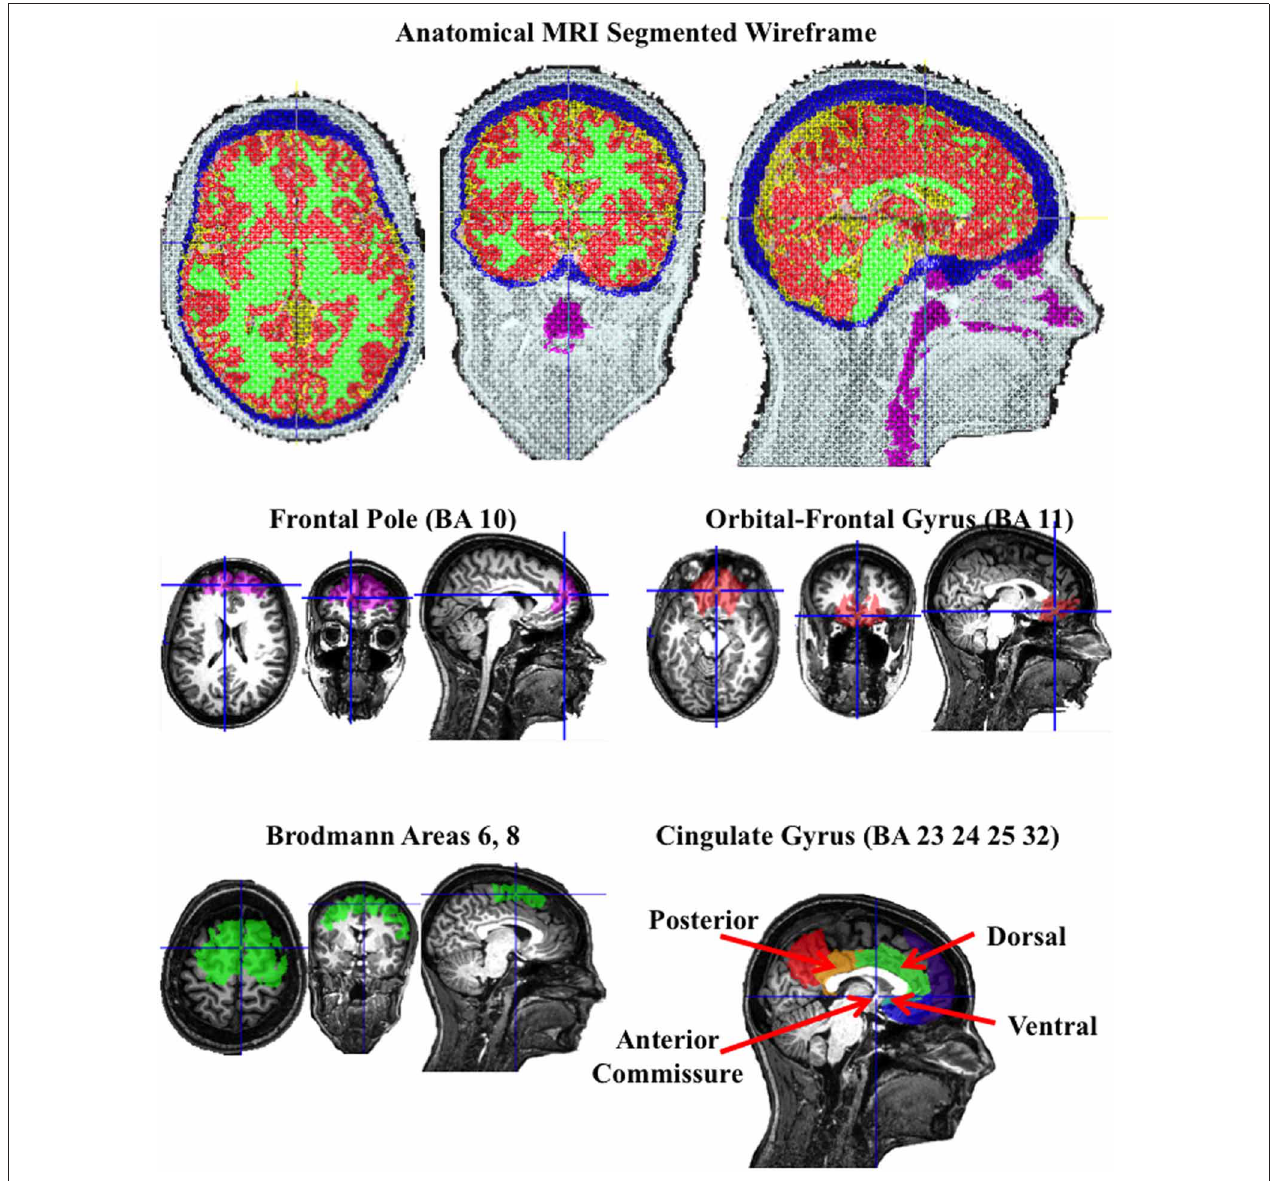
FIGURE 2 | A segmented wireframe from the anatomicalMRI from one individualparticipant showing scalp (white), skull (blue), CSF (yellow), graymatter(red),whitematter(green),andthenasalandthroataircavity